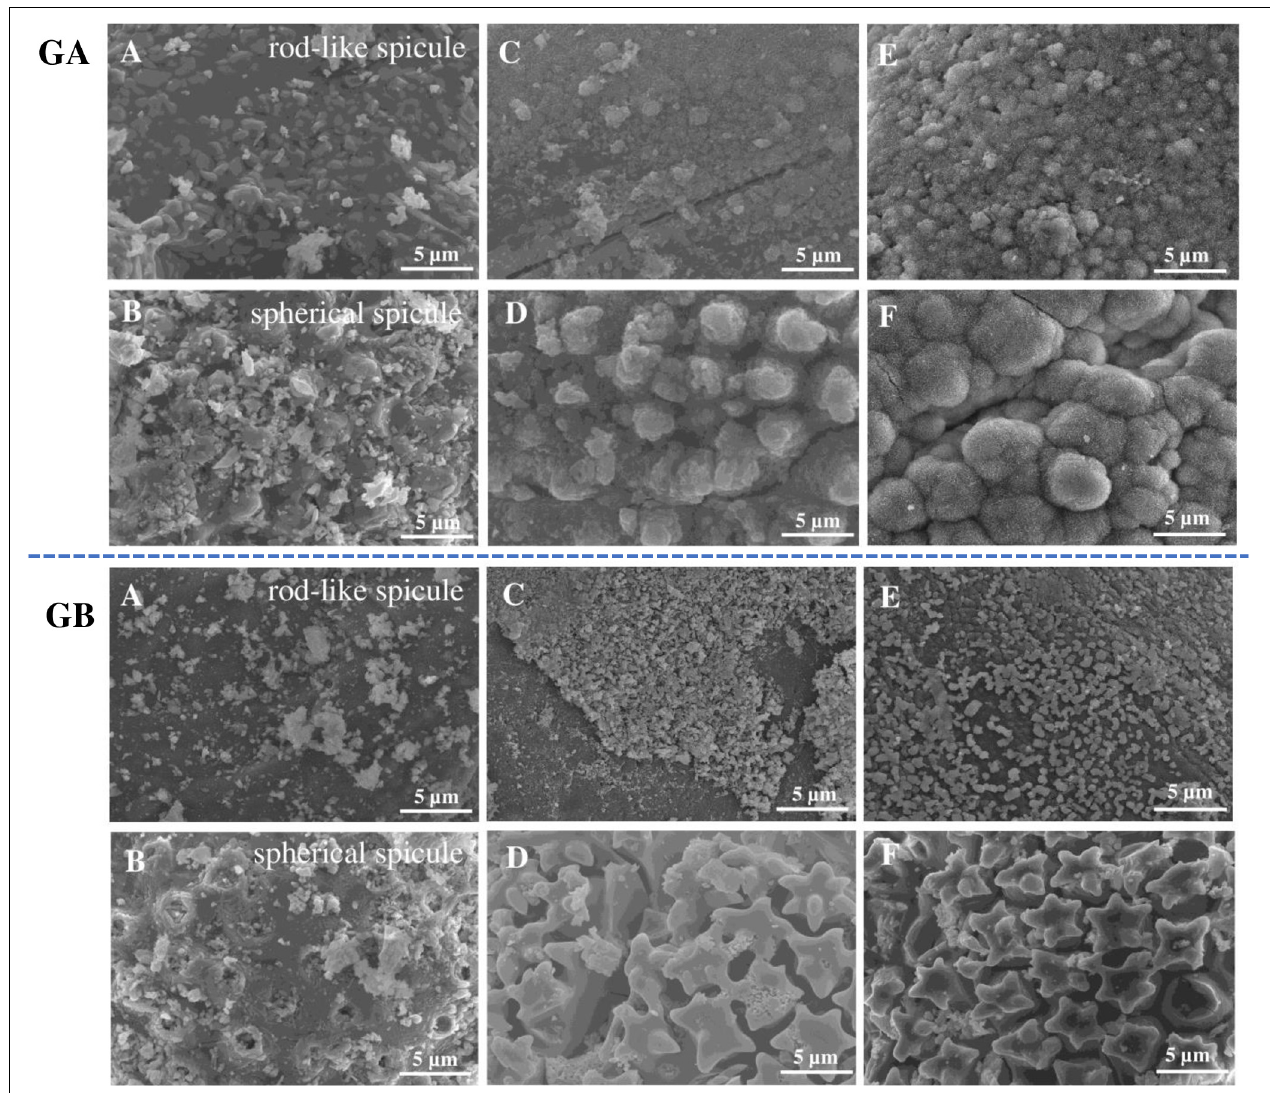
FIGURE 4 | SEM micrographs of the biosilicas obtained from GA and GB before immersion in SBF (A,B) , after 7 days of immersion in SBF (C,D) , and after 28 days of immersion in SBF (E,F) . Scale bar: 5 µ